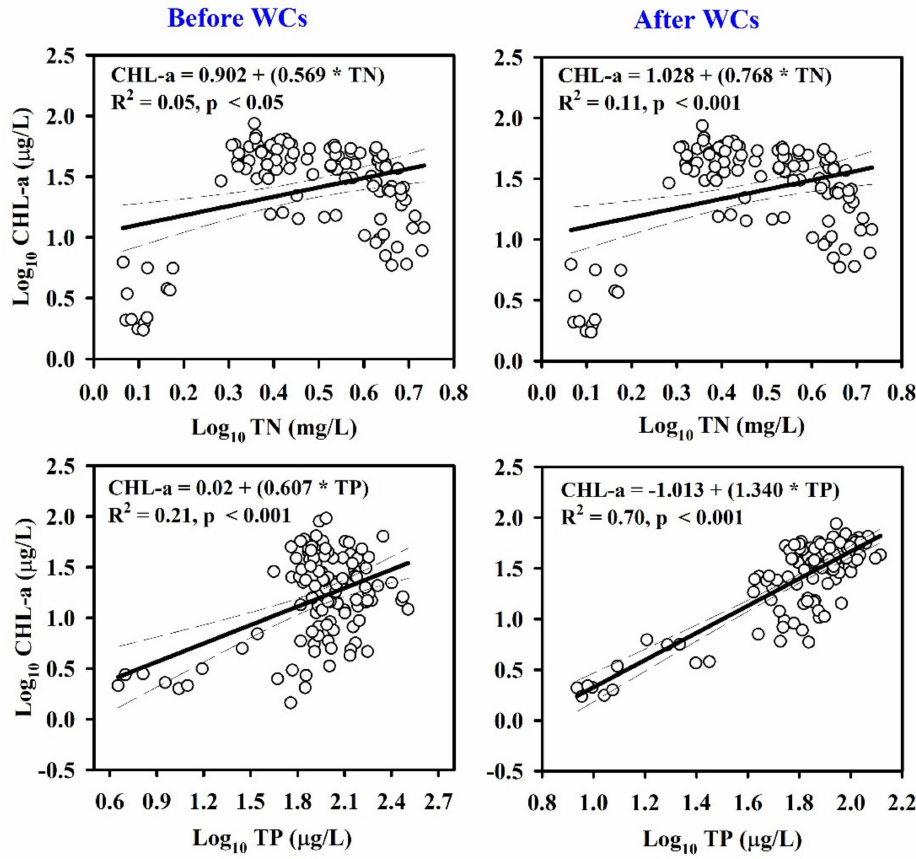
Figure 4. Relations of algal chlorophyll (CHL-a) with total nitrogen (TN) and total phosphorus (TP) in the Geum River before weir construction (WCs) and after the weir